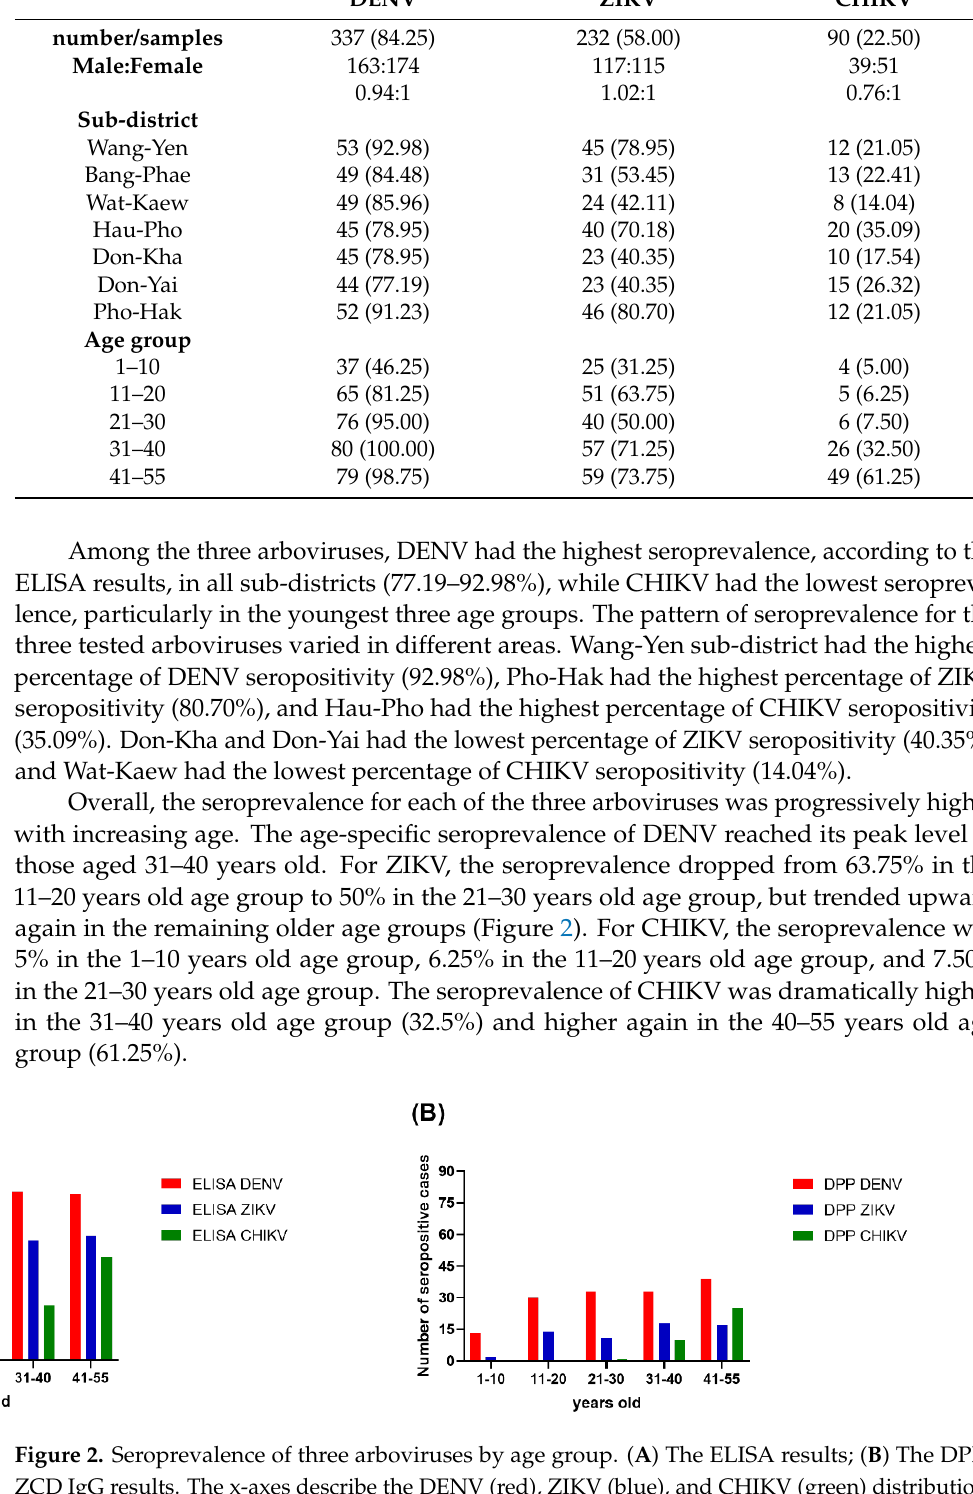
Figure 3. Seroprevalence of three arboviruses by residential area. ( A ) The ELISA results; ( B ) The DPP ® ZCD IgG results. The x-axes describe the DENV (red), ZIKV (blue), and CHIKV (green) dis- tributions for the seven sub-districts of Bangphae district, Ratchaburi province, Thailand. The y- axes represent the seroprevalence, as shown by the number of cases. 3.3. Co-Seropositivity for DENV, ZIKV, and CHIKV According to the ELISA results, 115 (38.75%) individuals were jointly positive for DENV- and ZIKV-specific IgG antibodies, and 64 (16.00%) were jointly positive for DENV-, ZIKV-, and CHIKV-specific IgG antibodies (Figure 4). The prevalence of IgG antibodies against all three arbo- viruses (DENV, ZIKV, and CHIKV) was highest in Hau-Pho sub-district (18 cases), followed by Bang-Phae sub-district (12 cases), and Pho-Hak sub-district (9 cases). The age group with the high- est joint seroprevalence of DENV and ZIKV was the 11 – 20-years-old group at 52.50%, whereas the highest joint seropositivity for DENV-specific and CHIKV-specific antibodies was 15.00% in the 41 – 55-years-old age group. The prevalence of IgG antibodies against all three arboviruses showed a gradual rise with age during early life (i.e., slightly higher prevalence in young adults than in children); however, the prevalence of these antibodies rapidly became higher with increasing ages above 30 years (Table 4). The highest co-seropositivity (38.75%) was seen for DENV-specific and ZIKV-specific antibodies. In contrast, only 25 (6.25%) of study participants were jointly seroposi- tive for DENV-specific and CHIKV-specific antibodies. The Chembio DPP ® IgG revealed 87 (21.75%) individuals as seropositive for DENV-specific IgG, 14 (3.50%) for ZIKV-specific IgG, and 10 (2.50%) for CHIKV-specific IgG. Moreover, the co-seropositive for both DENV and ZIKV IgG, and for DENV, ZIKV, and CHIKV IgG were 35 (8.75%) and 13 (3.25%), respectively.